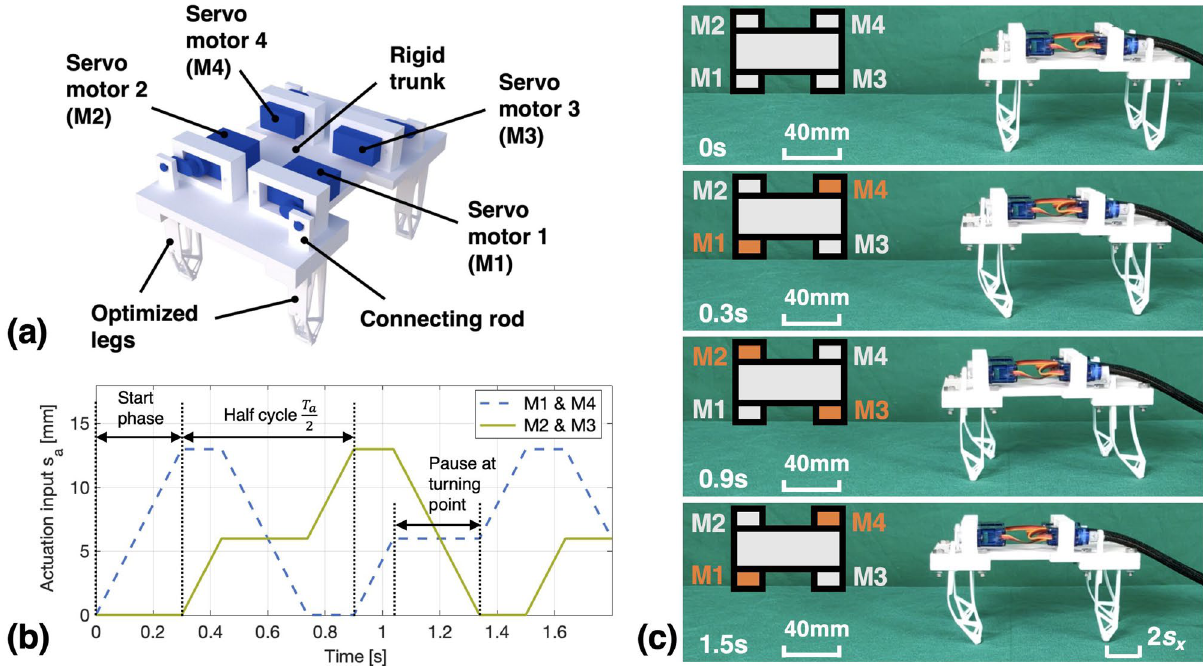
Figure 7. Experimental test of the walking performance of a 3D-printed quadruped robot with the optimized compliant legs: ( a ) Overview of the realized quadruped robot, ( b ) Actuation inputs for the two leg groups, ( c ) Generated walking motions of the robot. Here, the motor marked with orange color means that the connected leg is fully actuated ( s a = 13mm ), while the gray color means that the connected leg is undeformed ( s a = 0 mm